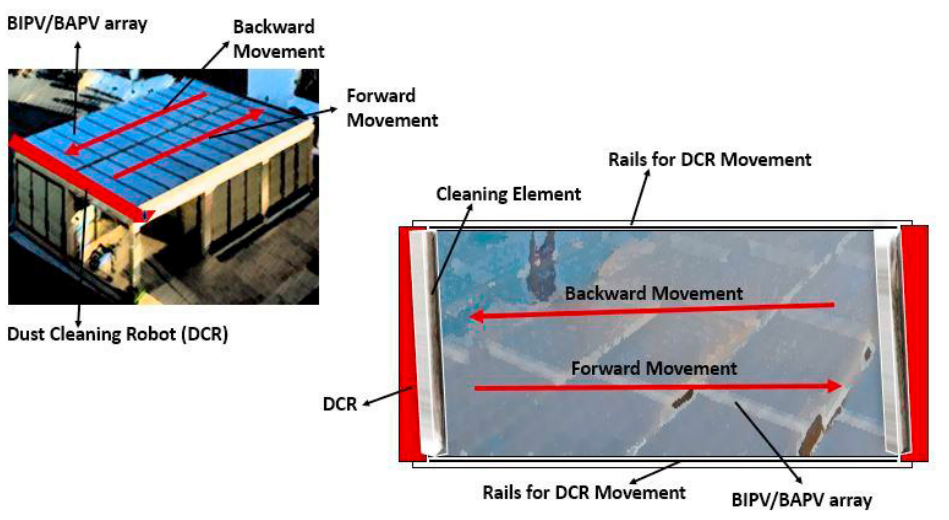
Figure 23. Adjustment of DCR on BIPV roof [62].